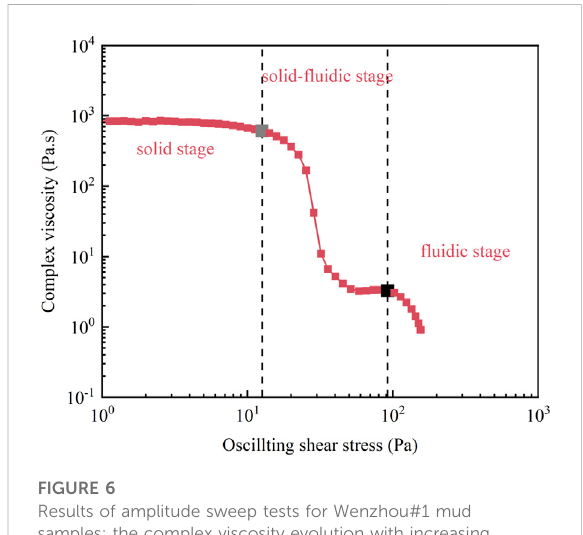
FIGURE 6 Results of amplitude sweep tests for Wenzhou#1 mud samples: the complex viscosity evolution with increasing oscillatory shear stress. In the fi gure, the grey point and the black point represent the fi rst yielding point and the second yieldingpointoftheWenzhou#1naturalmudsample,respectively.